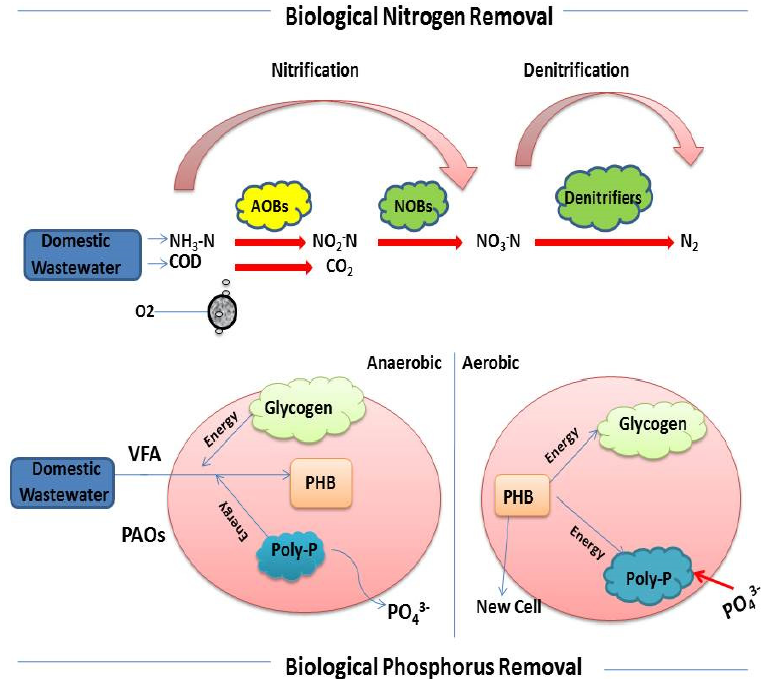
Figure 1. Mechanism of simultaneous nitrification denitrification (SND) for biological nitrogen and phosphorus removal.